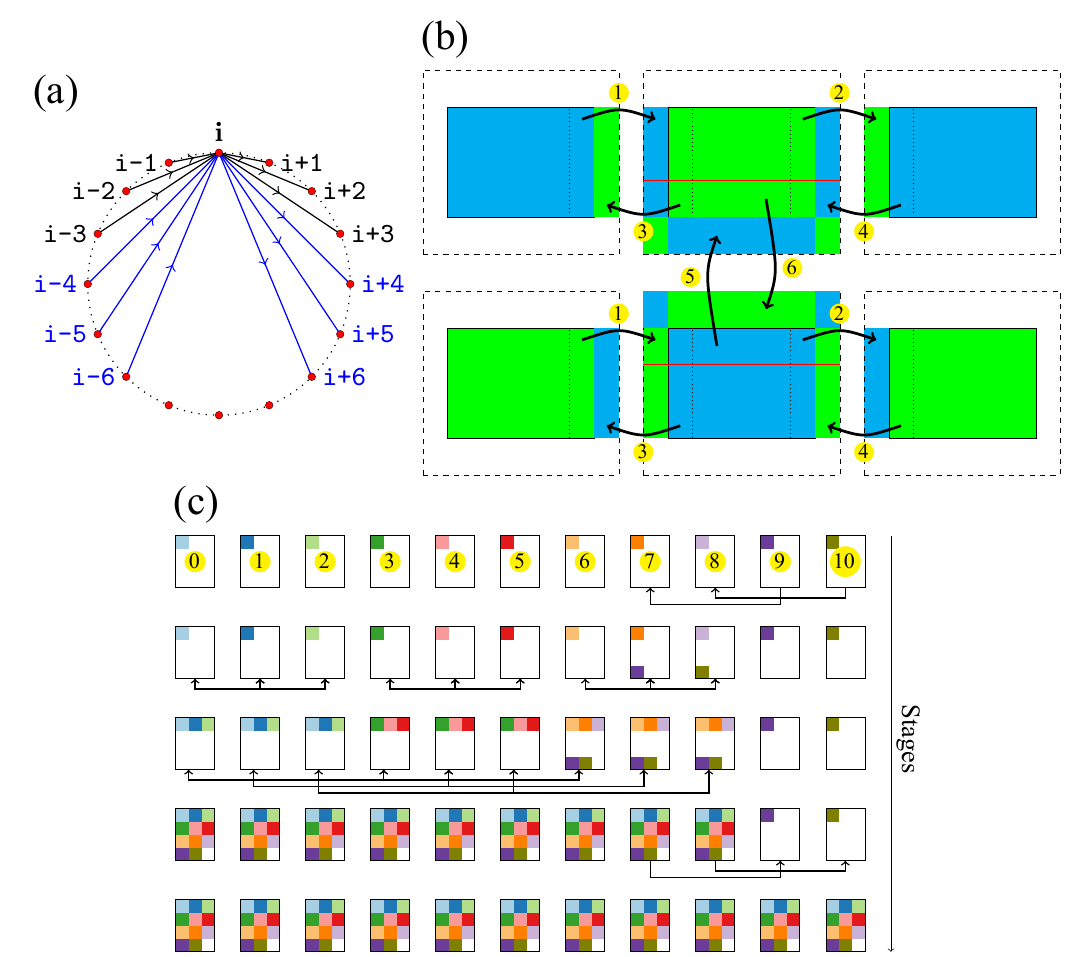
Figure 4. Algorithms for three key MPI operations: (a) is the ring- k algorithm with k radix for all-to-all personalized communication generalized from ring alltoallv algorithm, (b) is the halo exchange algorithm, and (c) is the recursive- k algorithm with k radix generalized from the recursive doubling